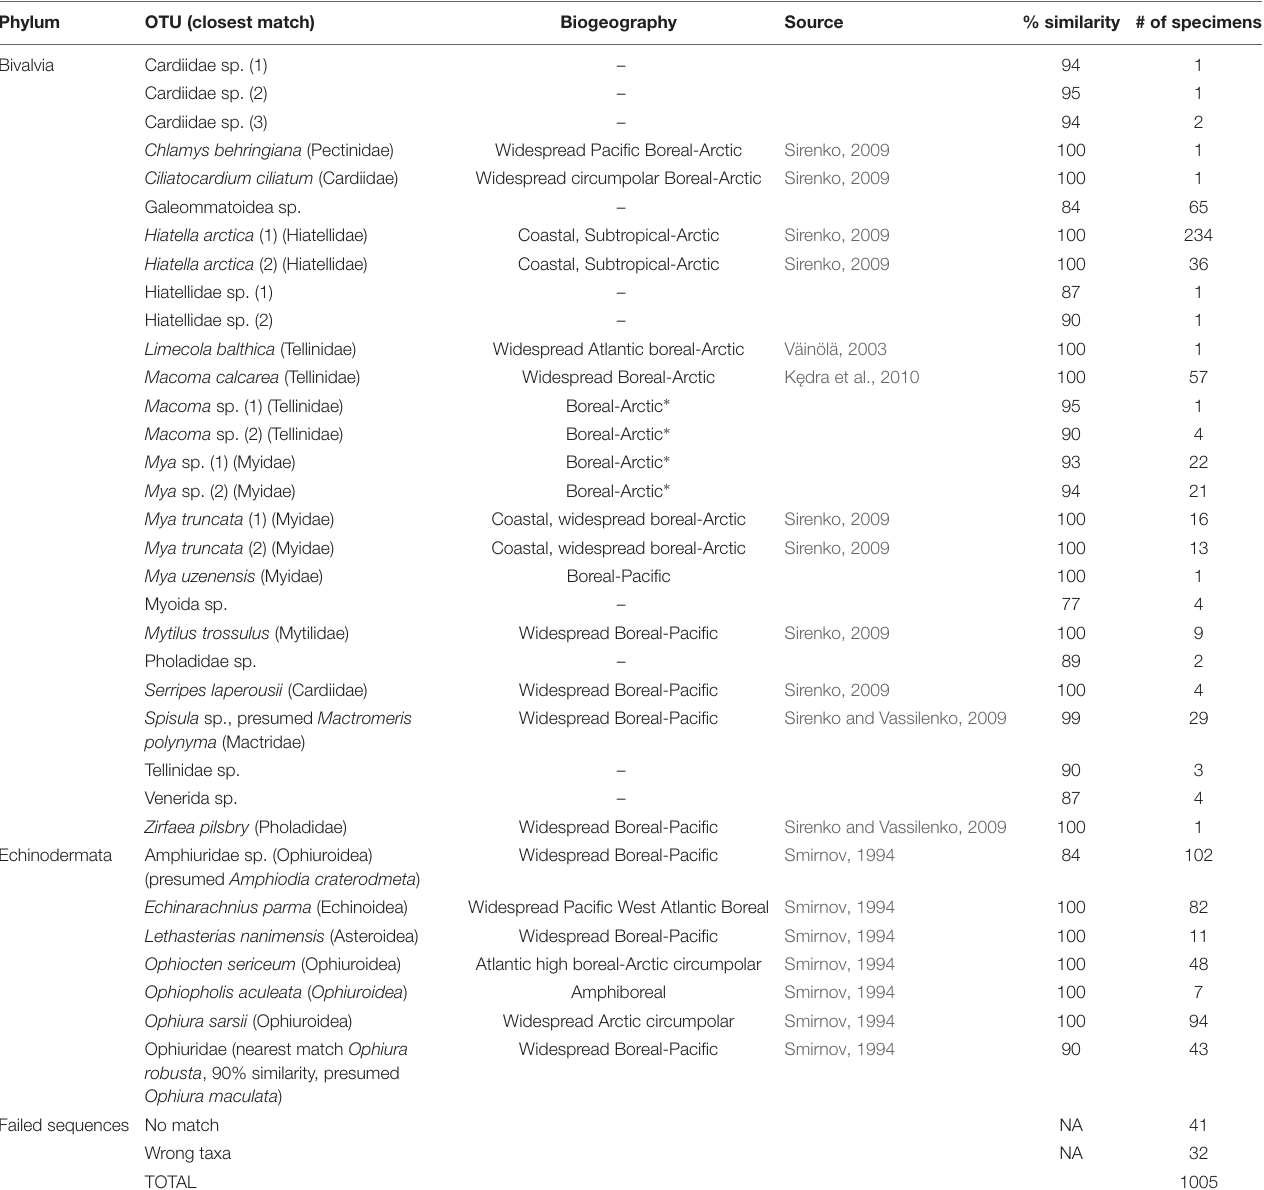
TABLE 3 | List of OTU’s identified using molecular